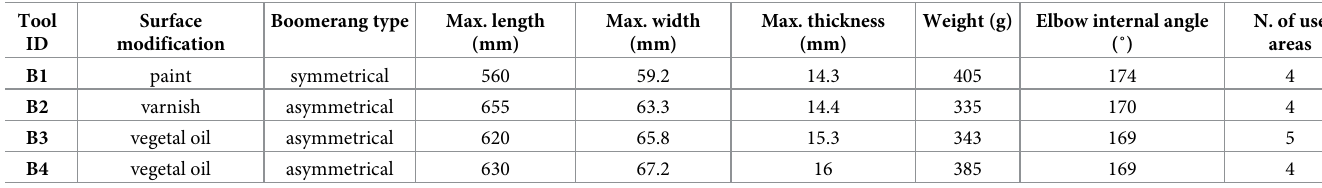
Table 2. Details of boomerangs used during retouching session